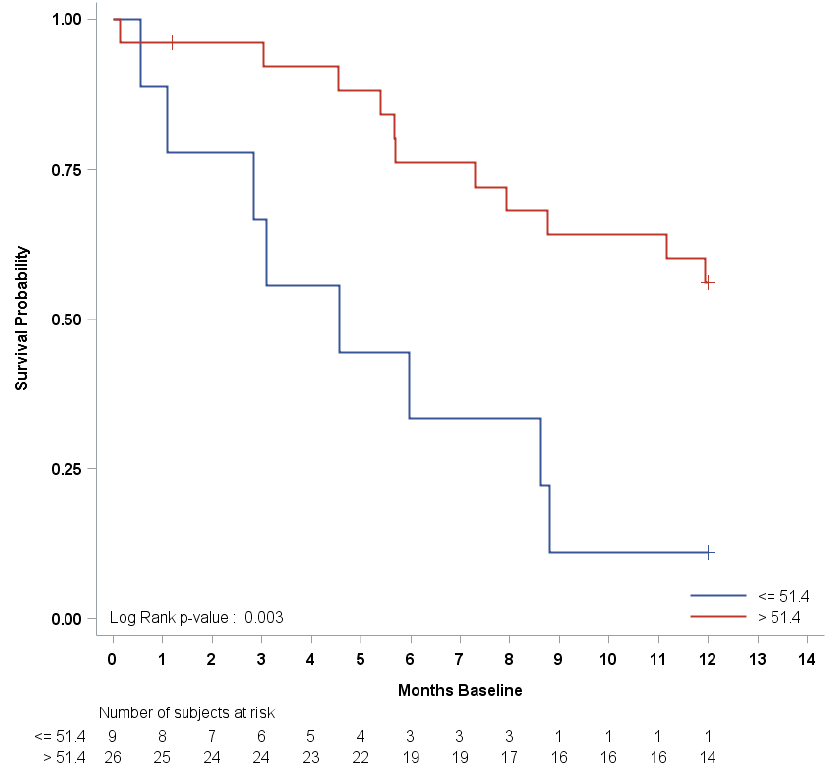
Figure 3. Progression-free survival Kaplan–Meier curve by first quartile of baseline PPC CD31- CD140b+. Table 3. Progression-free survival and overall survival risk estimates according to BAT median cut- off values at baseline.